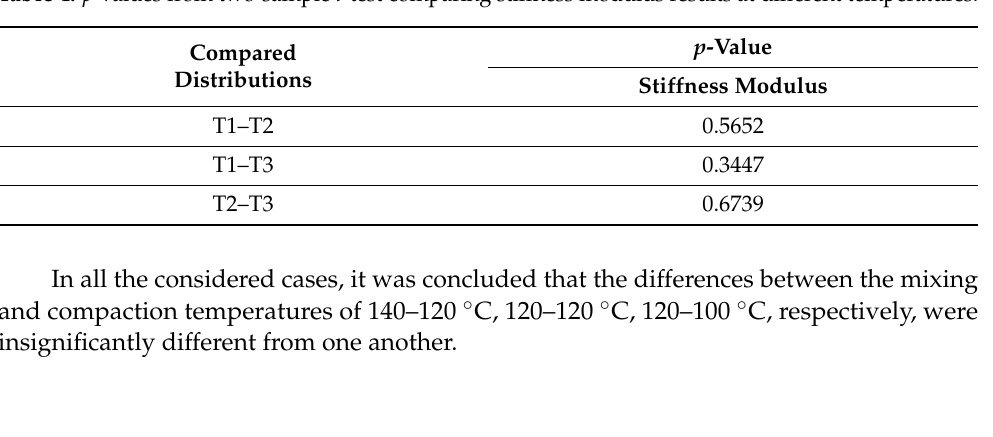
Table 4. p -values from two-sample t -test comparing stiffness modulus results at different